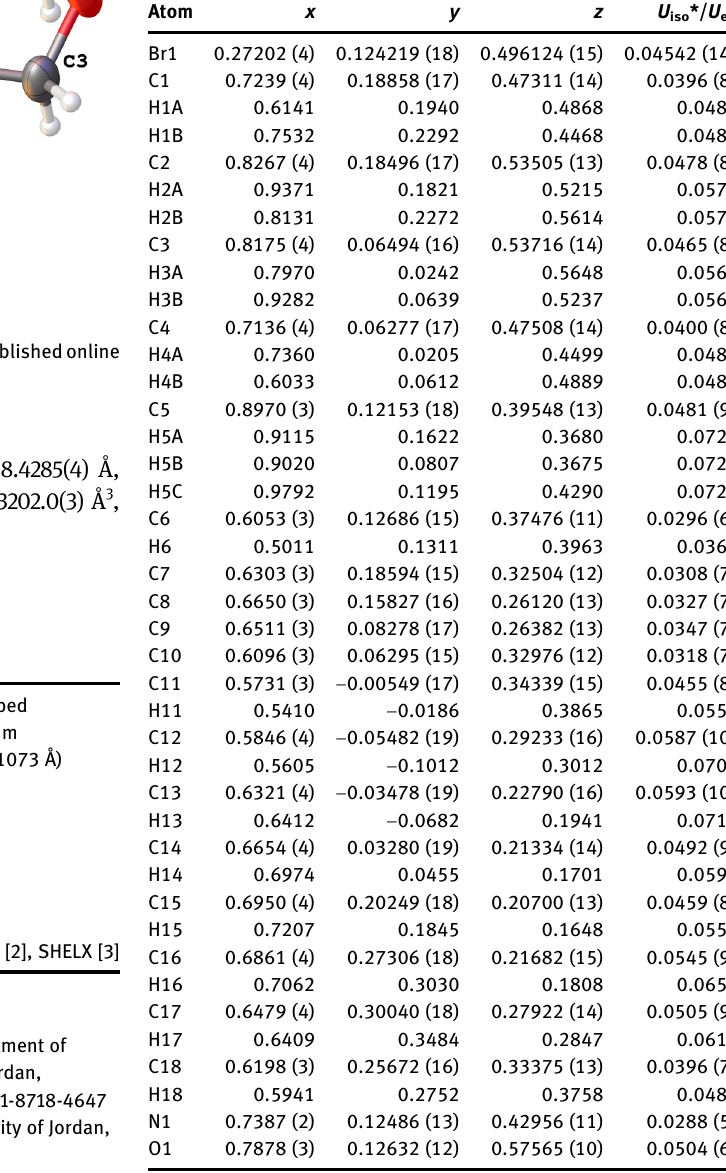
Table  : Fractional atomic coordinates and isotropic or equivalent isotropic displacement parameters (Å 